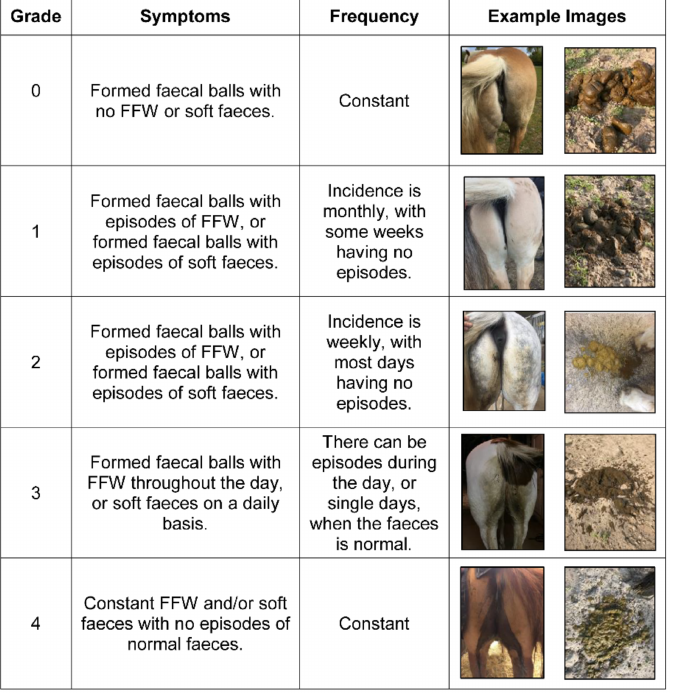
Figure 2. Symptom severity scale (SSS) used for grading free faecal water (FFW) symptoms in horses from 0 (no free faecal water) to 4 (maximum